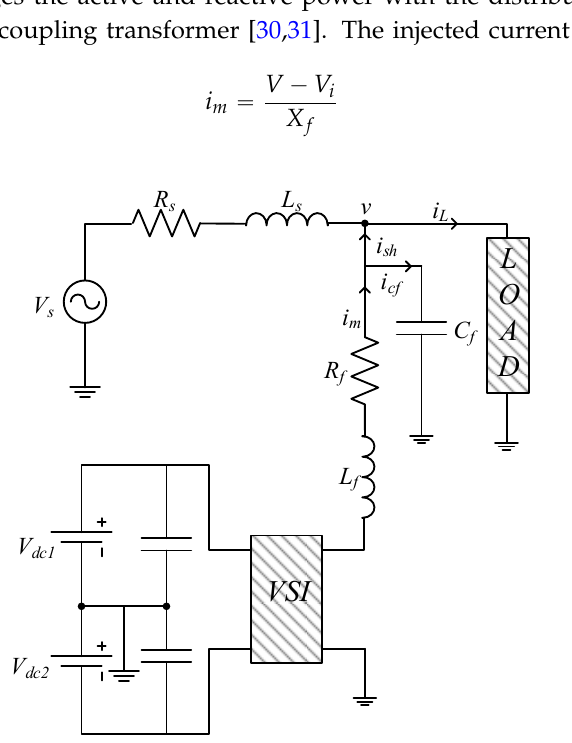
Figure 2. Basic structure of a distribution static compensator (DSTATCOM). VSI: voltage source inverter.